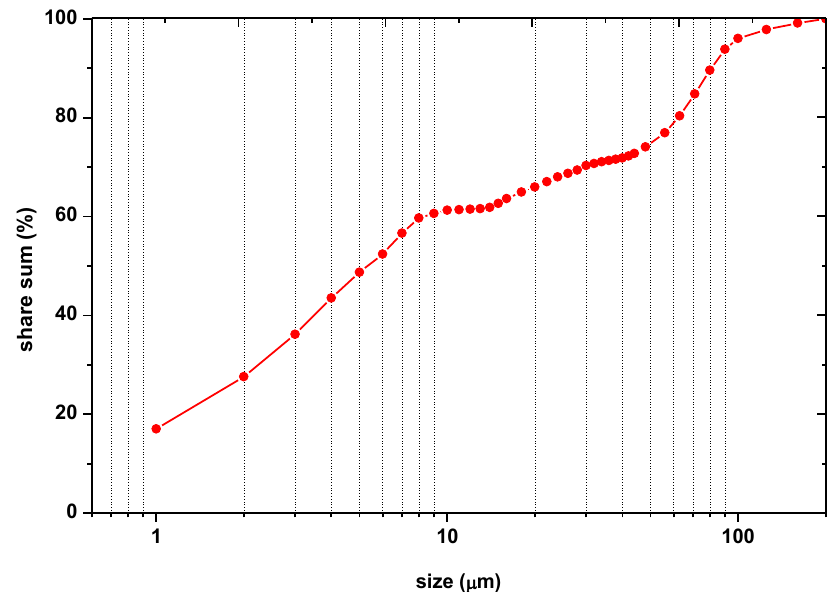
Figure 3. Distribution of grain size in the sample of post-floatation dolomites.